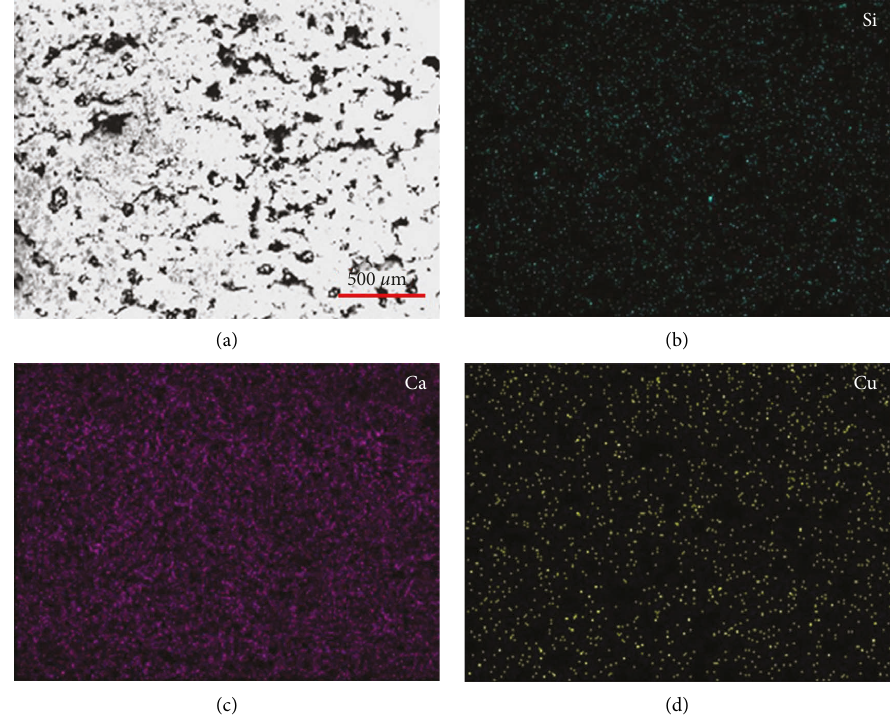
Figure 6: SEM image of the hardened cement composites with (a) 5.0% by weight Cu (b) silicon; (c) calcium; and (d)